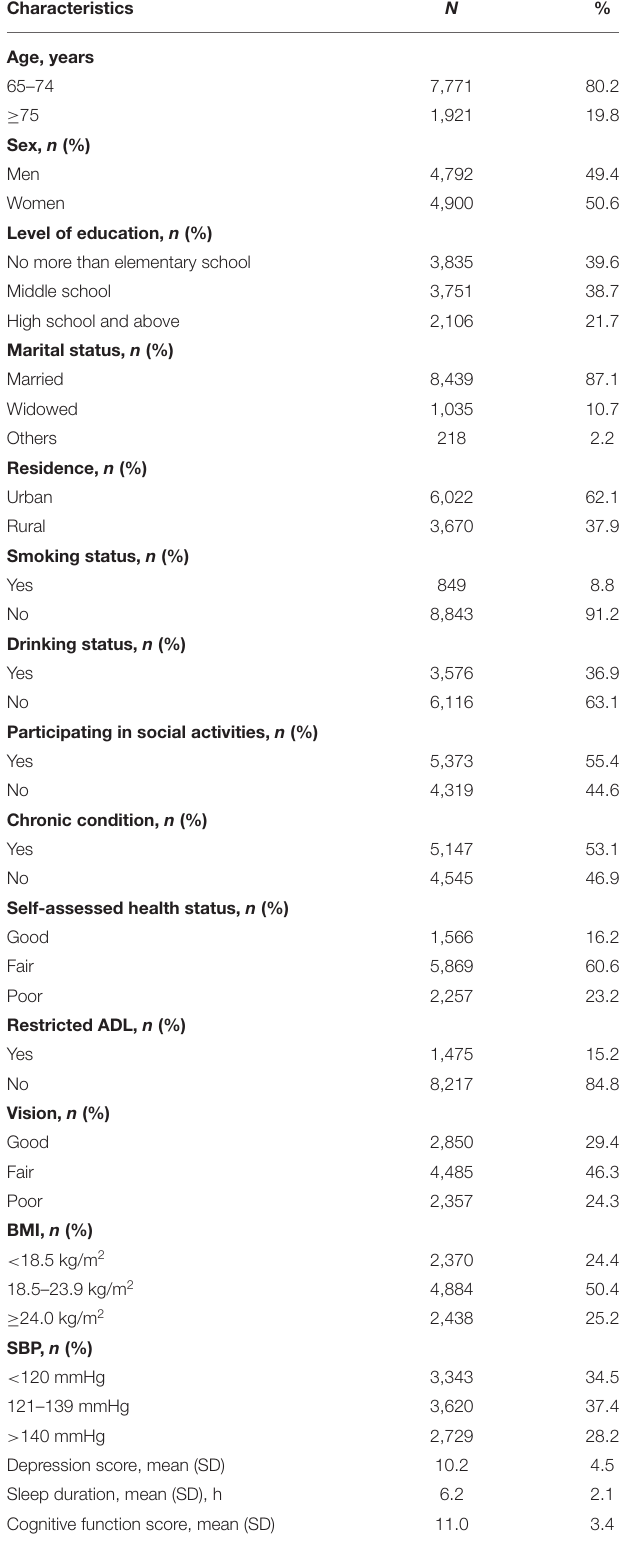
TABLE 1 | Demographic characteristics of study participants